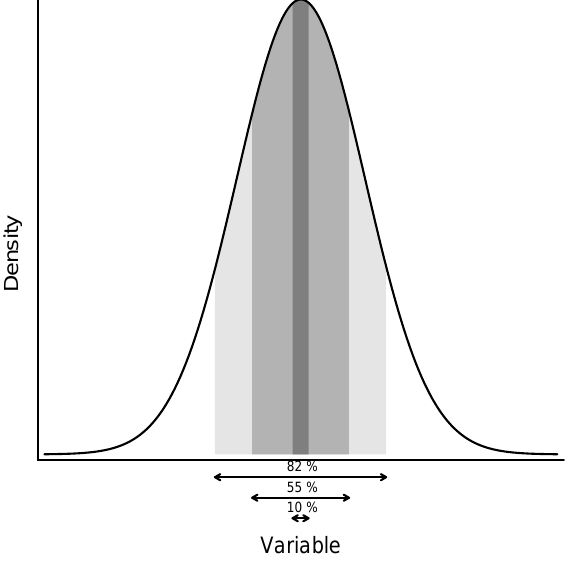
Figure 2. Example of the influence of pollen proportion (pp) on the calculation of the density of taxa presence intersection. The shades of grey indicate the effect of different pp when the pollen adjust- ment value (pa) is set to 0.9 and arrows indicate the assumed pres- ence range. The first case (dark grey) results from pp = 1 . 0, which represents the highest detectability and is assumed to be found near the core distribution area and, thus, near-optimum conditions. The presence is assumed in a narrow range around peak density with × pa α = pp (corresponding to 10% of the area). When pp = 0 . 5 2 (medium grey) the corresponding area is 55% and with pp = 0 . 2 (light grey) is used the widest presence range (82% of the PDF